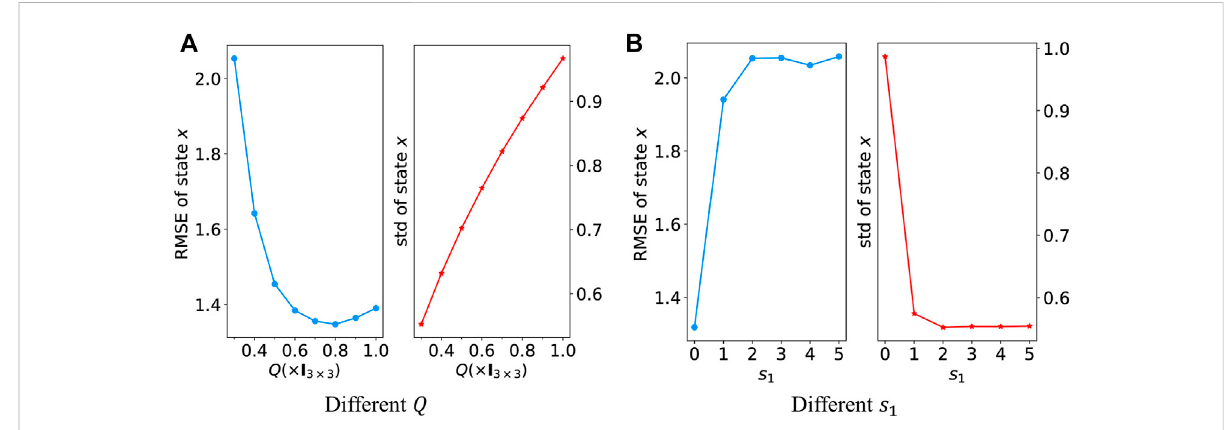
FIGURE 7 RMSE and standard deviation of state x with a different values of Q and s 1 . (7A) Shows the results with different Q values when fi ltering and (B) shows the results with different s 1 values in Eq. 11. A smaller Q or larger s 1 indicates better particle